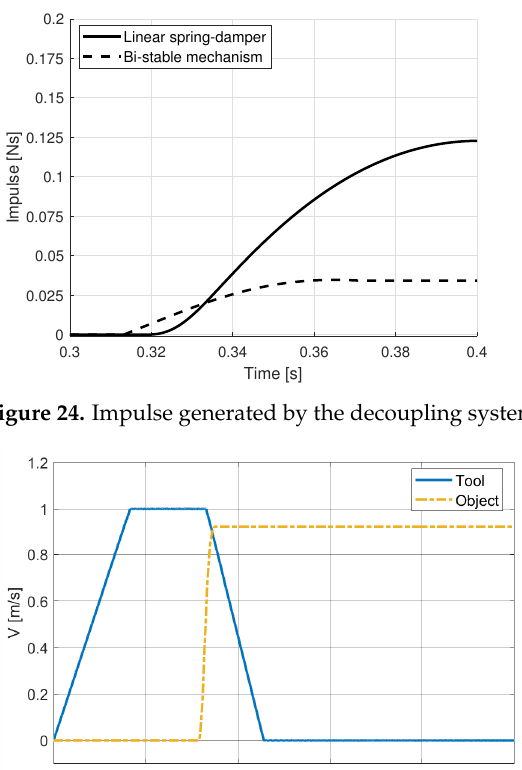
, m t = 0.125 kg and m 1.5